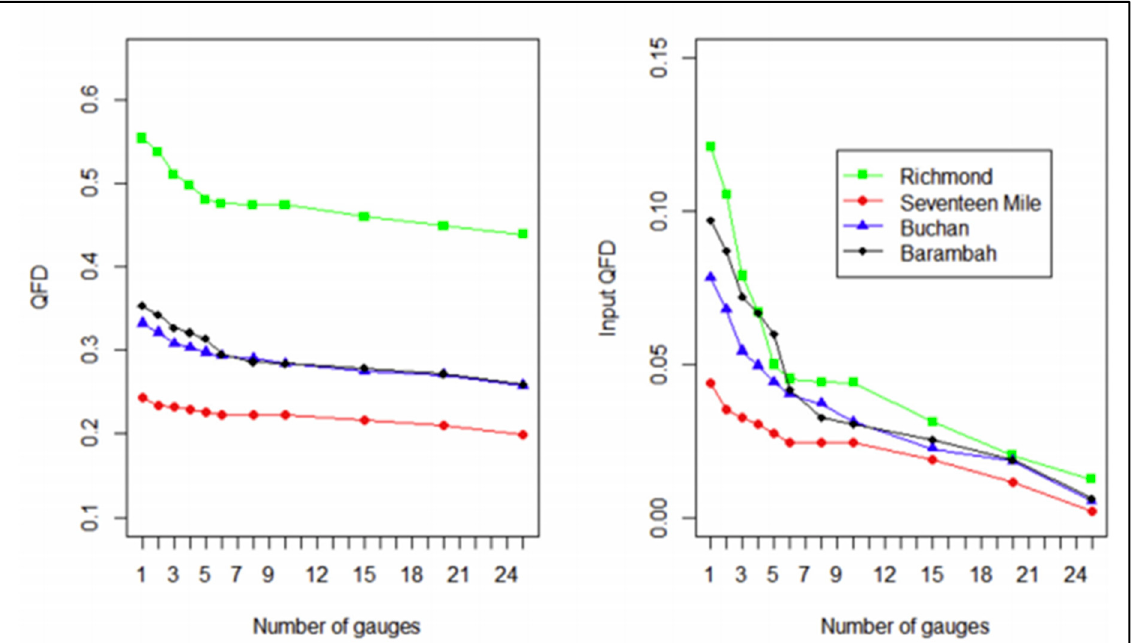
Figure 7. Experimental investigation shows that the augmented number of gauges reduce the overall uncertainty calcu- lated through the Quantile Flow Deviation metric (QFD) [80,81]. Here, we showed how we can quantify uncertainty, considering the availability of data across four different catchments in Australia, named as (i) Richmond catchment at New South Wales (NSW); (ii) Seventeen Mile catchment at Northern Territory; (iii) Buchan River catchment, Melbourne, Victoria; (iv) Barambah River catchment at Queensland. The Australian Water Availability Project (AWAP) data set from the Bureau of Meteorology, Canberra, Australia is used for this analysis. Four parent hydrological models (TOPMODEL, ARNOXVIC, PRMS, SACRAMENTO) are used in this experimental setup.